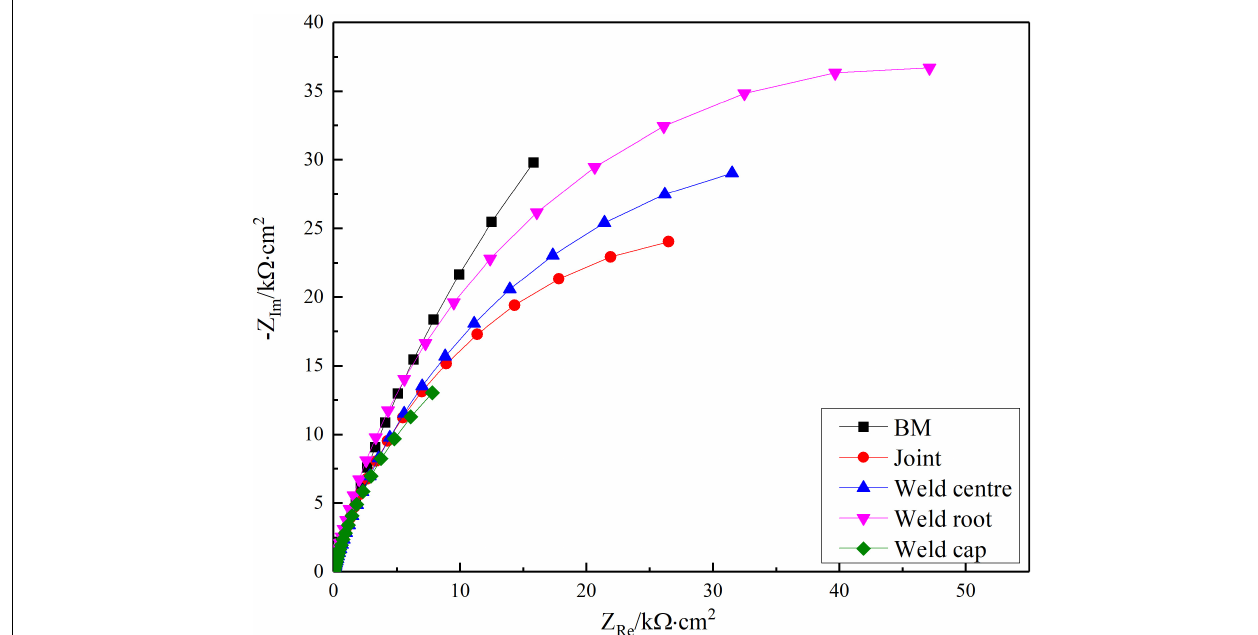
FIGURE 11 | EIS fitting results of different zones of the weld joint: Nyquist.